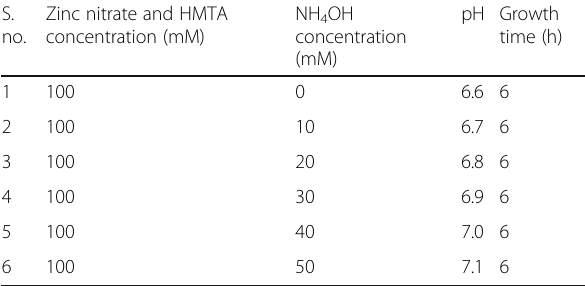
Table 1 HTG parameters for ZnO nanomaterial produced for each NH 4 OH concentrations at 85